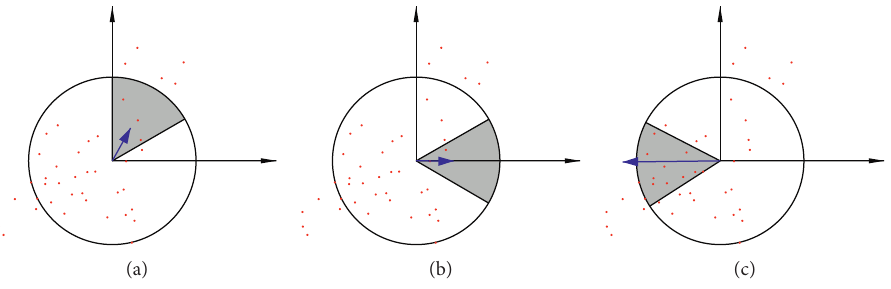
Figure 8: Determination of the main direction of feature points.